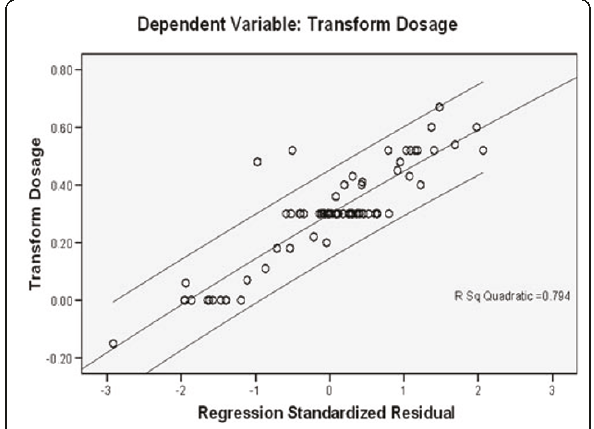
Figure 2 Correlation between warfarin dose and model 4 predicted value